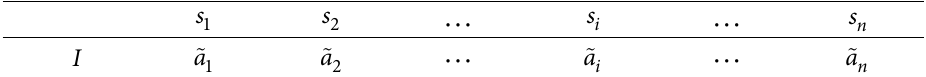
Table 1. Ideal strategy